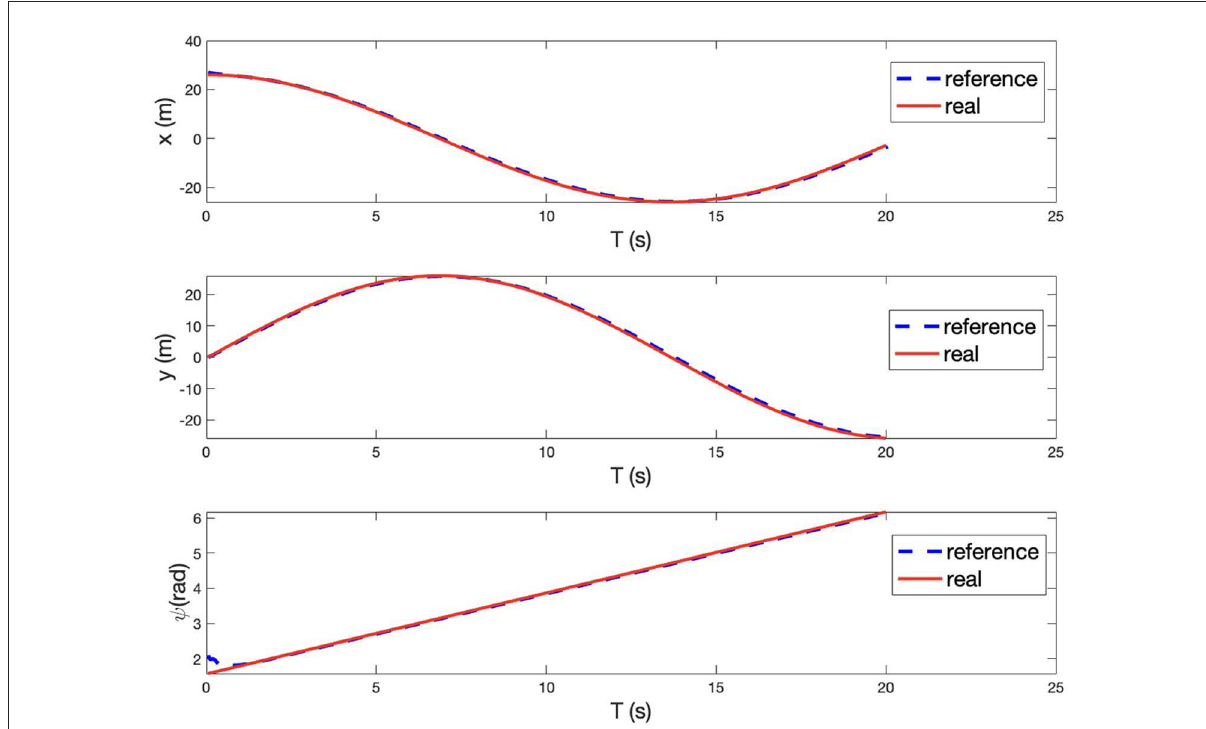
FIGURE12 Longitudinal position, lateral position, and yaw angle of the reference trajectory and of the baby stroller when following the circle path.